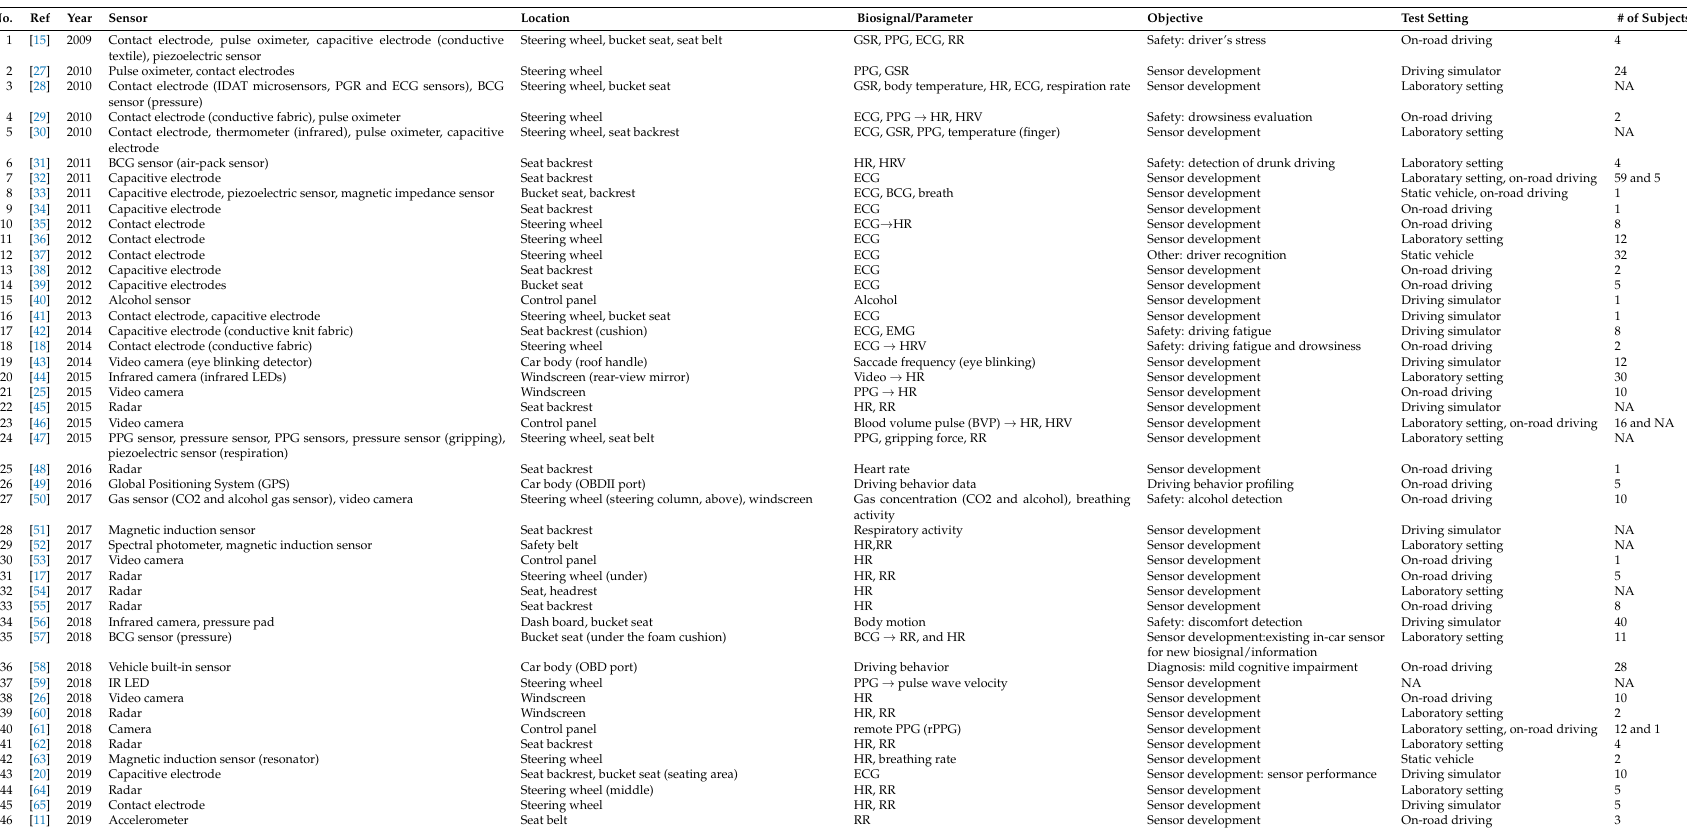
Table 1. Included research on in-vehicle health monitoring. The articles are ordered by ascending year. NA: the information is not